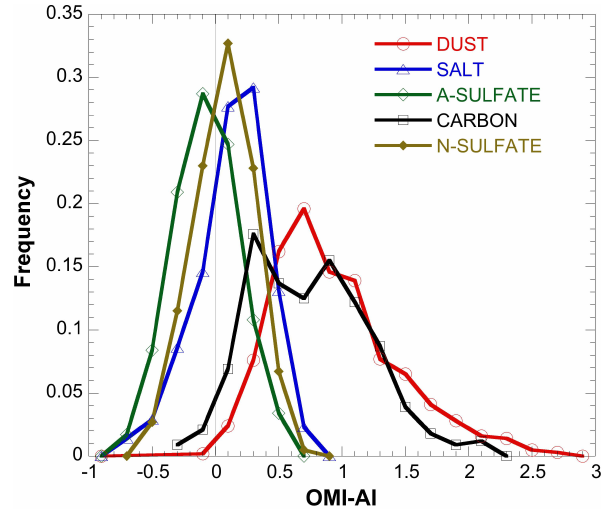
Fig. 3. Frequency distribution of OMI-AI for each aerosol type. Note that the AI frequency distribution of dust and carbon is dis- placed to the right (more positive) of the other aerosol